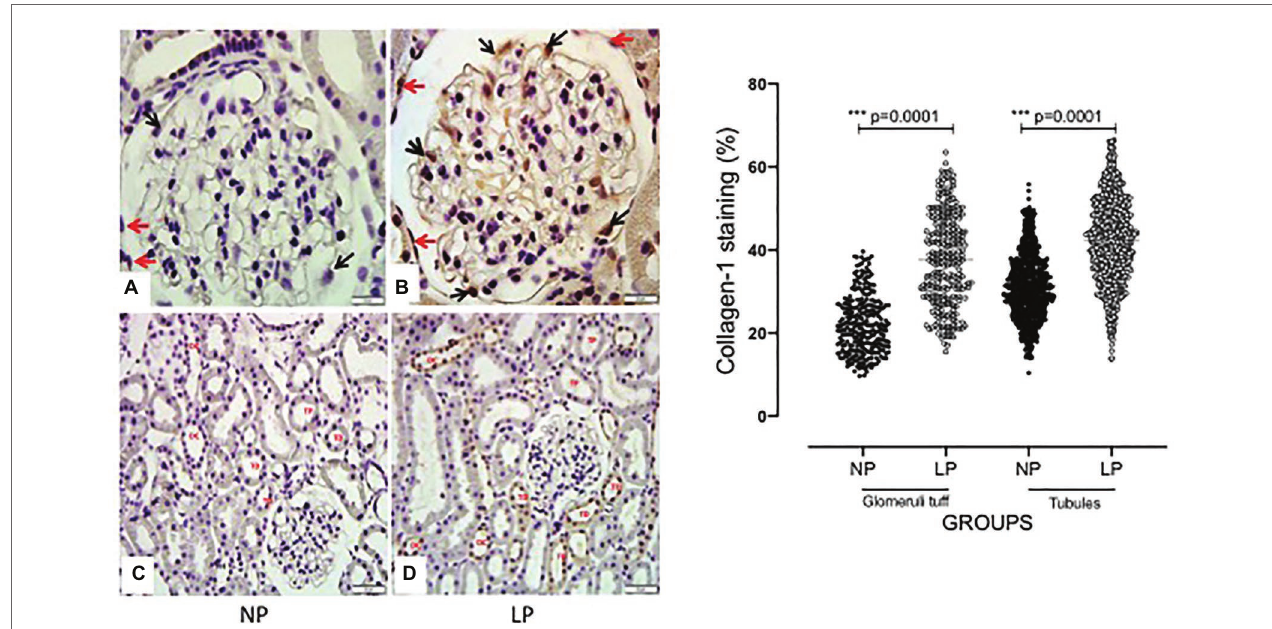
FIGURE 7 | Glomerular and tubular collagen-1 immunoperoxidase staining in 24-week-old male NP offspring ( n = 5; A/C ) compared with age-matched LP progeny ( n = 5; B/D ). A 400× and 1000× magnification was used in the tubular area (A,B) and glomerular area (C,D) , respectively. The scale bar can be found at the bottom right of each figure. Five cortical and medullar fields of each histological section were analyzed, and the average immunoreactivity reading was determined. Data are presented as scatter dot plots on the right; the unpaired Welch’ ANOVA test was used for data analysis. The level of significance was set at p < 0.05.